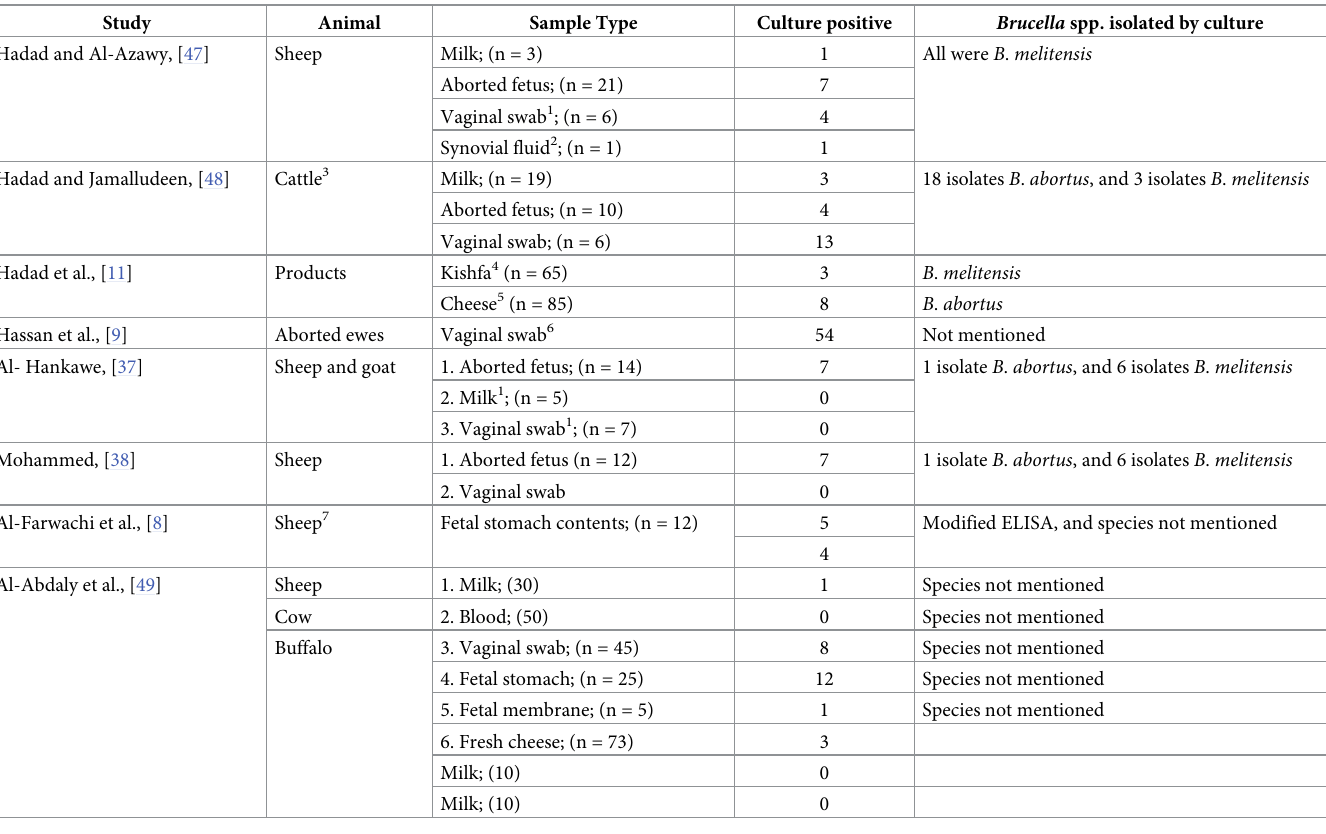
Table 3. Qualified studies that examined brucellosis in different food-producing animals in Mosul, Iraq, with main objective: Isolation of Brucella